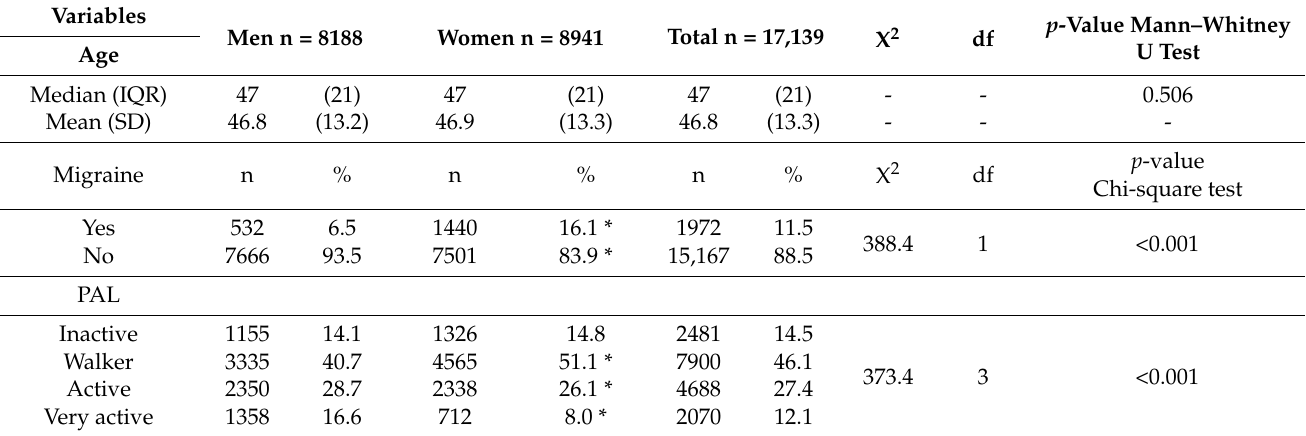
Table 1. Descriptive analysis of the general population: age, prevalence of migraine, and level of physical activity. Comparison between sexes and dependence analysis between categorical variables and